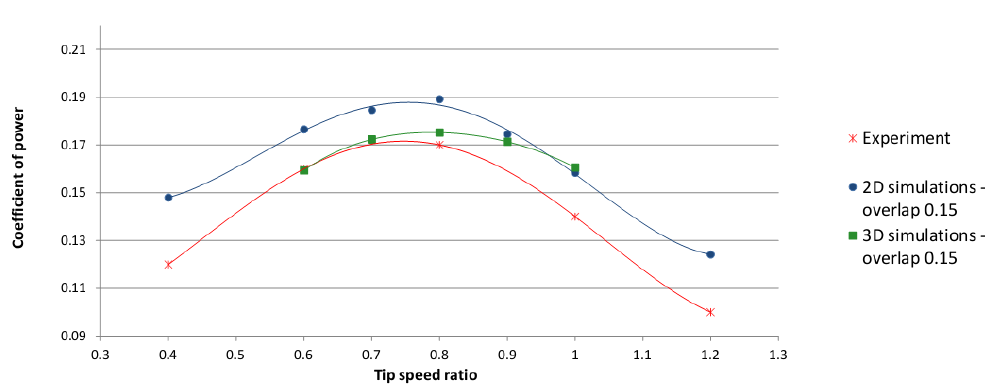
Figure 4: Comparison of the C p coefficient from simulations and experiment